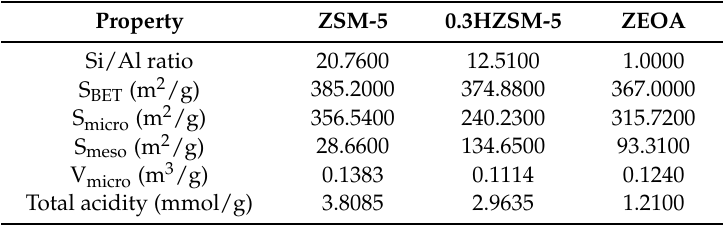
Table 1. Textural characteristics of ZSM-5, 0.3HZSM-5 and ZEOA.